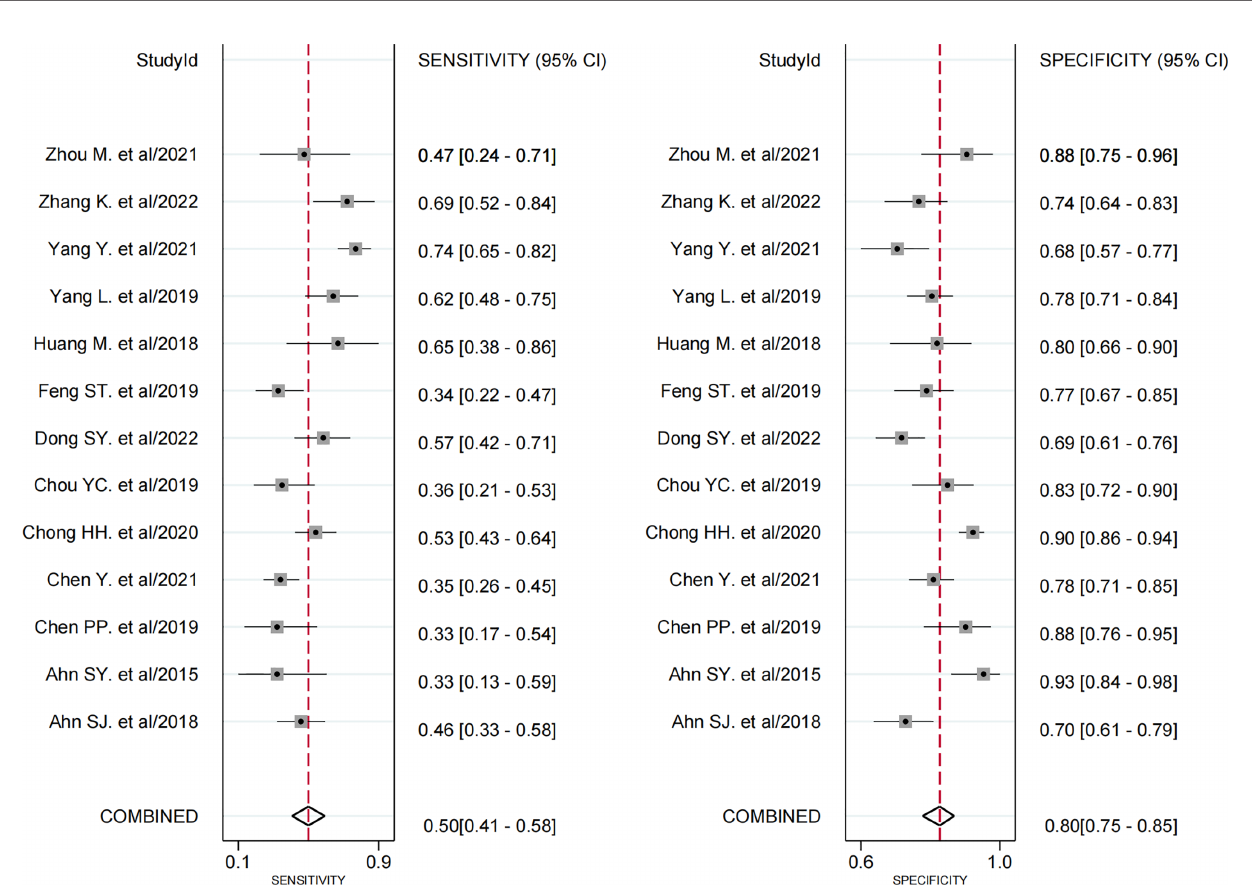
FIGURE 3 | Forest plots demonstrate the pooled sensitivity and speci fi city of peritumoral enhancement on the arterial phase. The 95% CI are shown around point estimates and the pooled